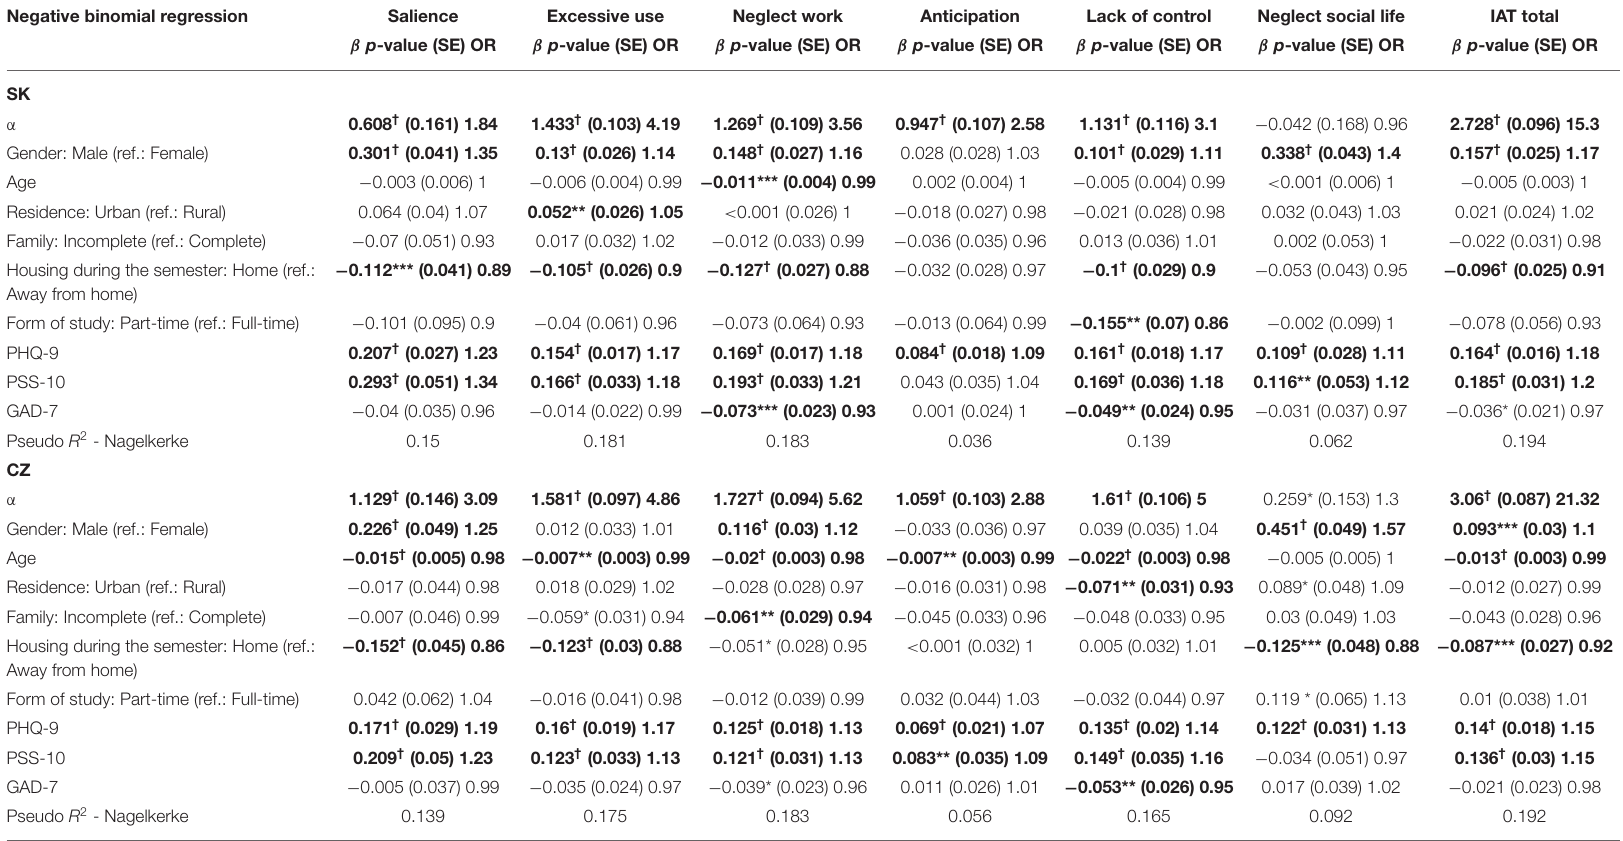
TABLE 12 | Relationships of the IAT and its subscales with selected socio-demographic, academic, and psychological characteristics. Negative binomial regression Salience Excessive use Neglect work Anticipation Lack of control Neglect social life IAT